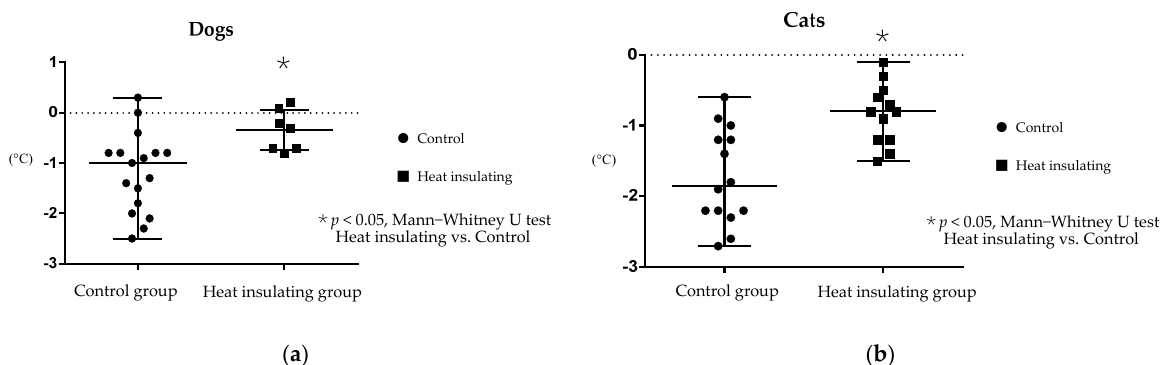
Figure 4. Changes in body temperature measured rectally during a magnetic resonance imaging (MRI) examination for the control group and the heat insulating group (filled circle, control; filled square, heat insulating; central large bar, me- dian; upper and lower bars, maximum and minimum, respectively). The change in body temperature was recorded from the time of anesthesia induction to the end of the MRI examination. A decrease in body temperature was significantly prevented in the heat insulating group compared to the control group ( p < 0.05, Mann–Whitney U test). ( a ) indicates dogs; ( b ) indicates cats.